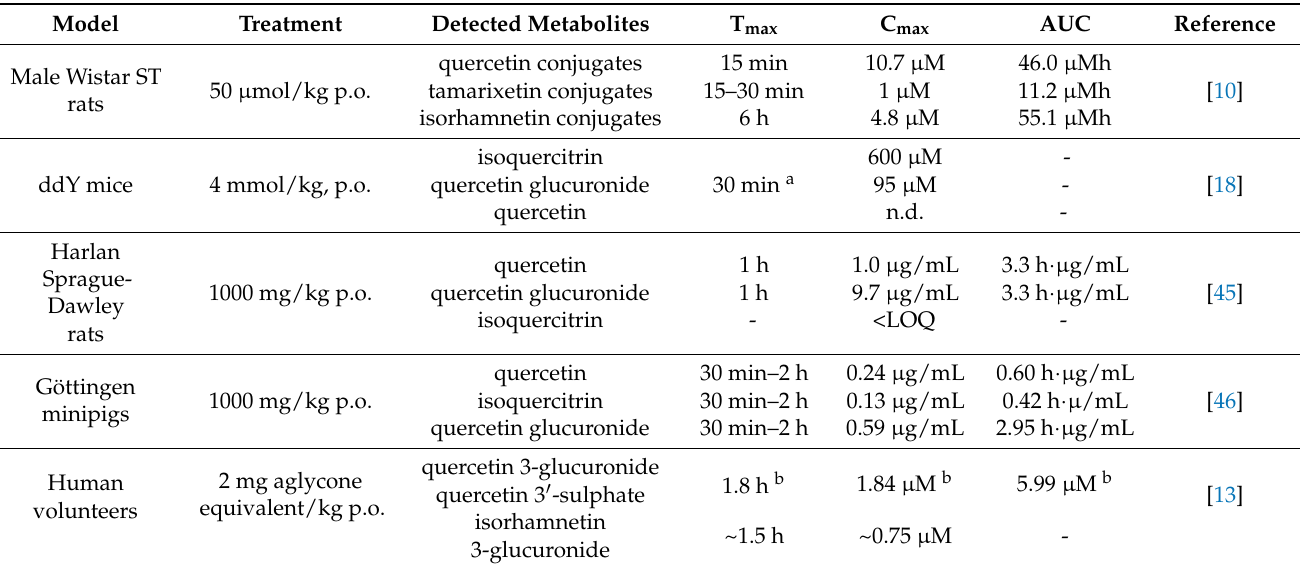
Table 1. EMIQ metabolites detected in plasma after oral administration and their pharmacokinetic